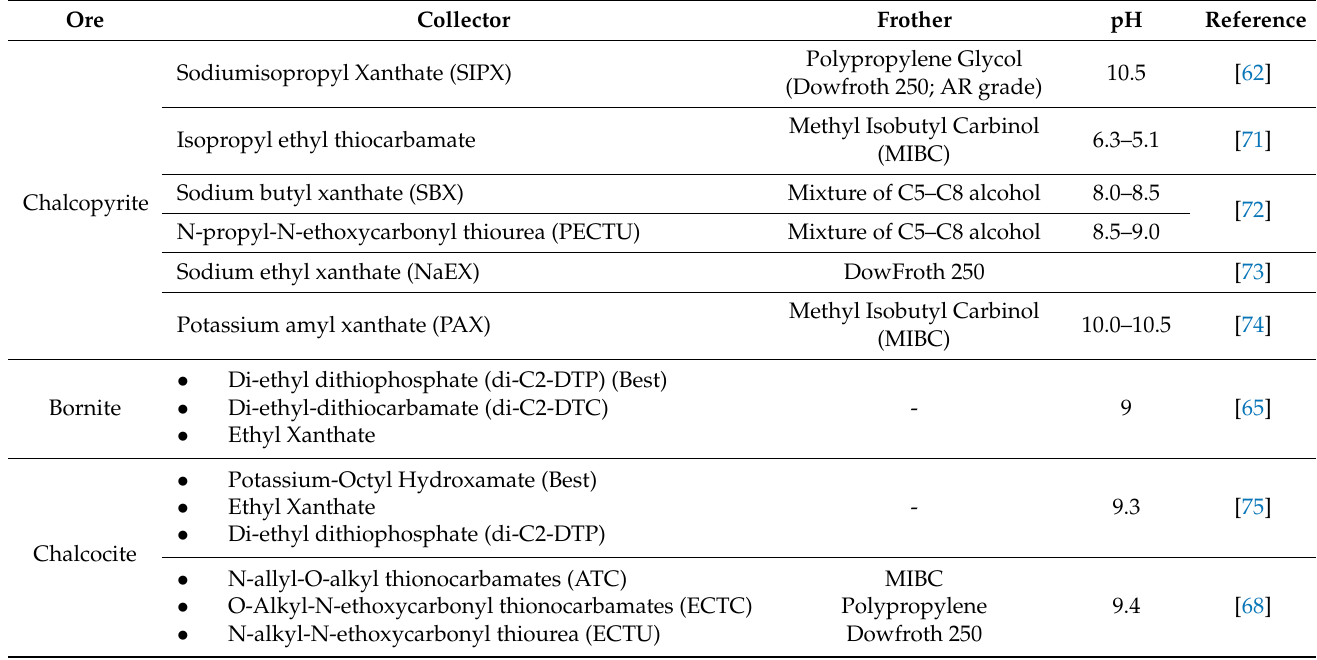
Table 6. Common reagents for copper sulphide mineral